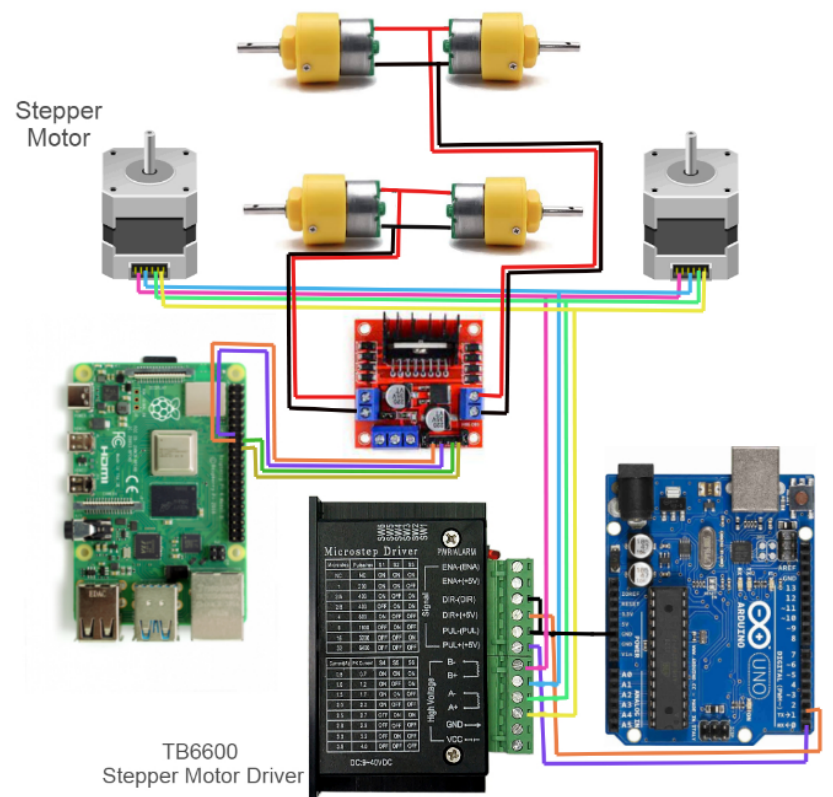
Figure 2. Circuit Diagram: part A.